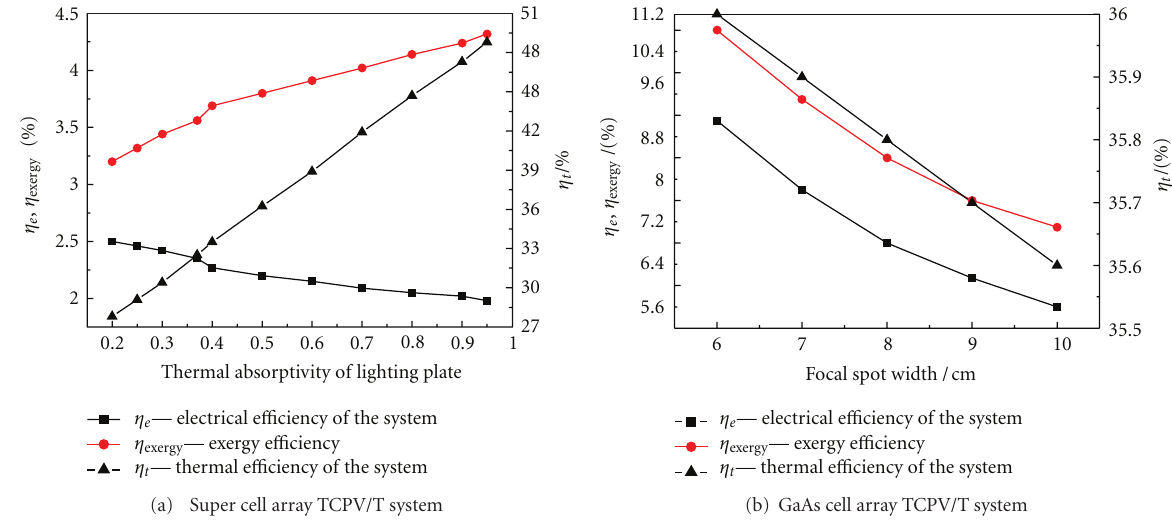
Figure 8: The influences of focal spot widths on the system